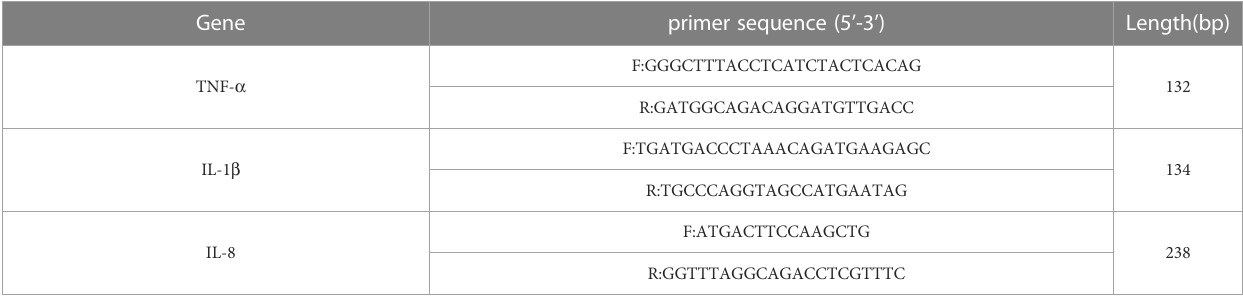
TABLE 2 Primer sequences of the